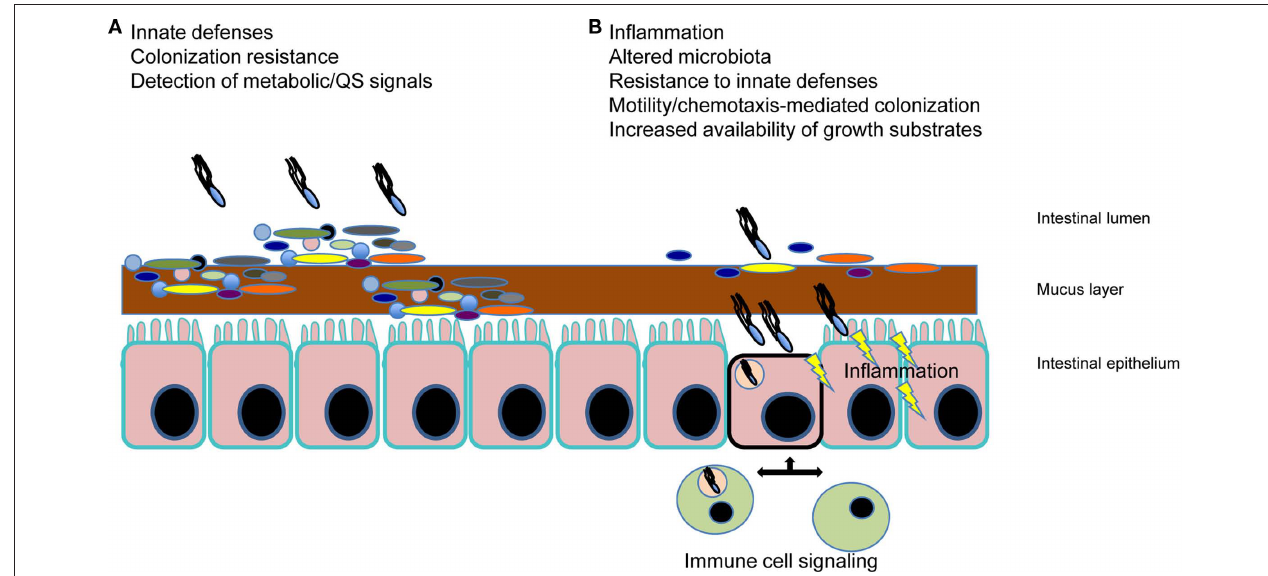
manifestation. This inflammation is a result of motile Salmonella and SPI-1- mediated invasion of M-cells in Peyer’s patches and enterocytes, as well as PAMP signaling. Phagocytic cell uptake and subsequent host cell signaling results in alteration of the microbiota, further induction of host innate resistance mechanisms (to which the bacteria respond with their own induced resistance), and the increased availability of growth substrates, some which specifically allow Salmonella to outcompete the microbiota. Perturbation of the microflora (e.g., antibiotic/probiotics) also creates an altered gut environment that can affect Salmonella